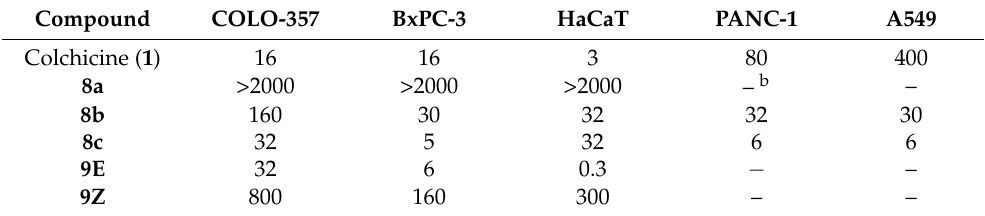
Table 1. Antiproliferative activity of compounds 8a – c , 9Z and 9E (IC 50 , nM a